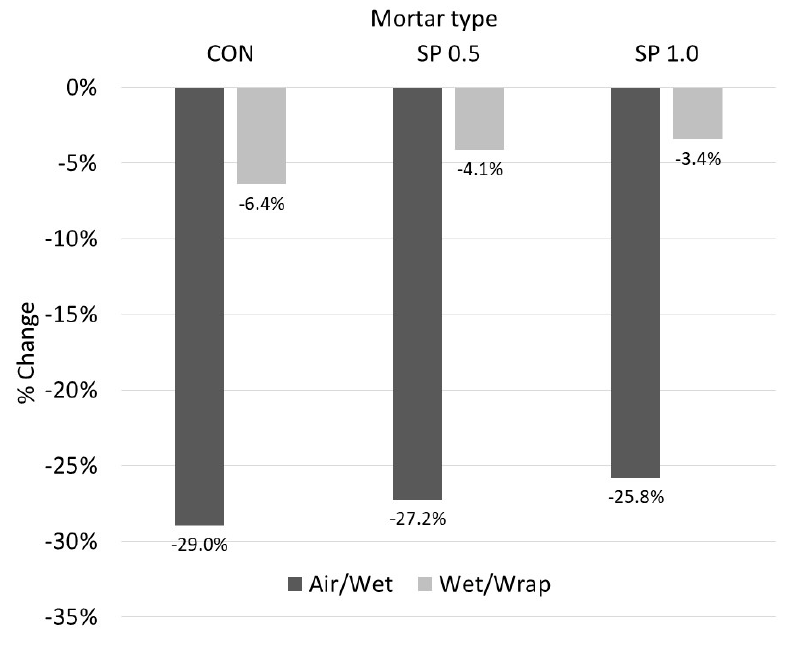
Figure 5. Percentage strength change vs. curing condition (28